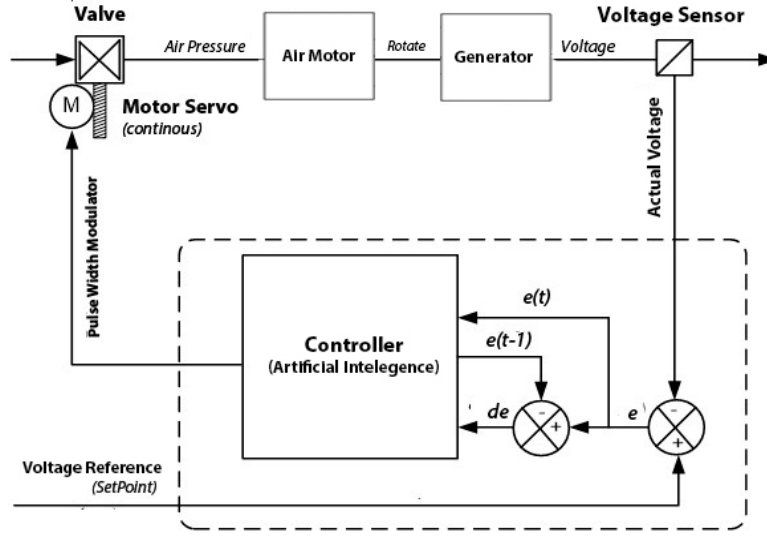
Figure 3. Control block of prototype SS-CAES.